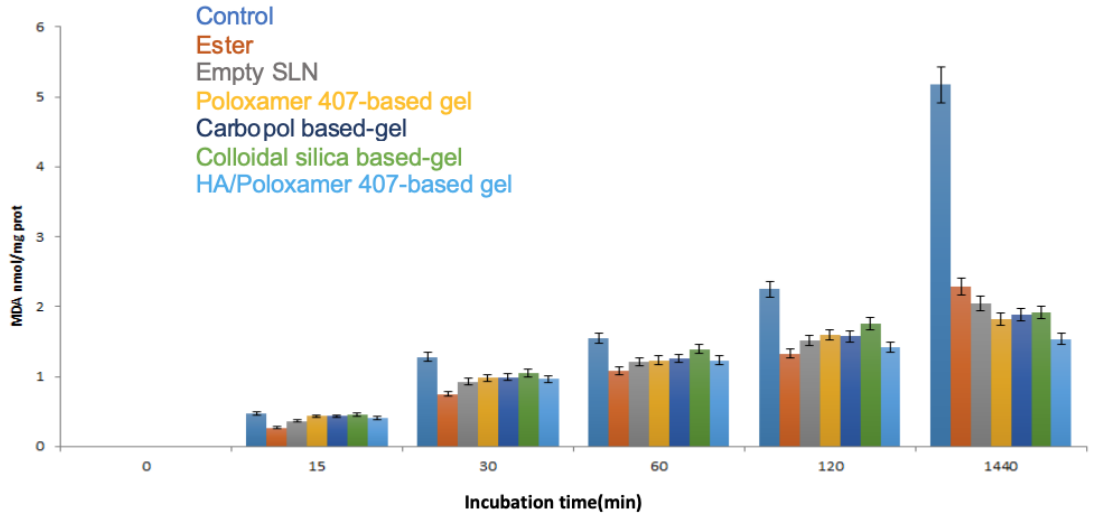
Figure 5. In vitro antioxidant activity.